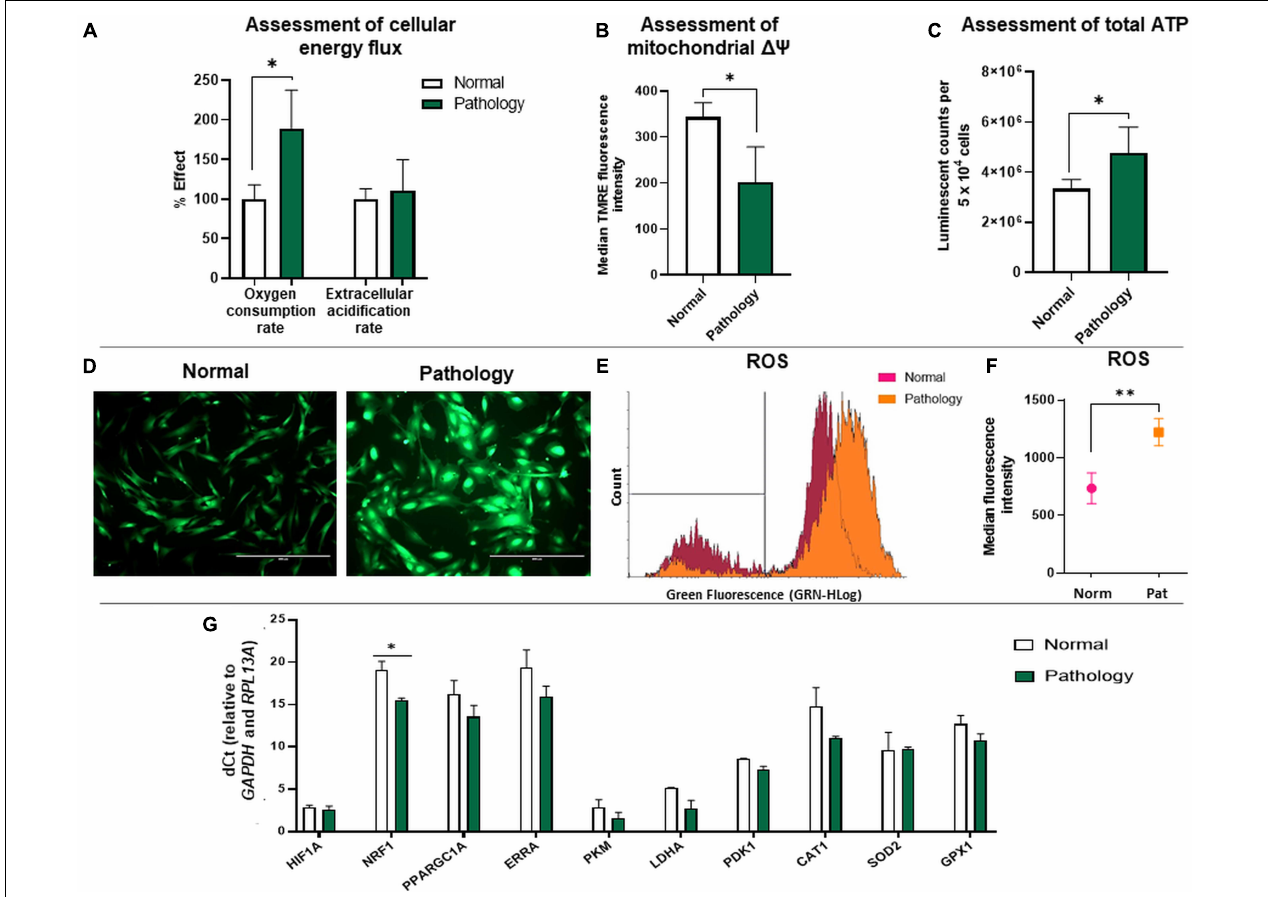
FIGURE 2 | Cellular bioenergetics analysis of hAFSCs from normal and fetus-affected gestations. (A) Assessment of cellular energy flux for hAFSCs, obtained from fetus-unaffected (Normal, n = 3) and fetus-affected (Pathology, n = 3) gestations, shown as a percentage relative to hAFSCs from fetus-unaffected gestations. Comparative measurements were taken using Abcam Extracellular oxygen consumption assay (ab197243) and Abcam Glycolysis assay (ab197244). (B) Analysis of mitochondrial membrane potential ( (cid:49) ψ m) of hAFSCs, obtained from fetus-unaffected (Normal, n = 3) and fetus-affected (Pathology, n = 3) gestations; values are indicated as mean ± SD. Analysis was performed using Abcam TMRE Mitochondrial membrane potential assay kit (ab113852). (C) Assessment of cellular energy content (ATP) of hAFSCs, obtained from fetus-unaffected (Normal, n = 3) and fetus-affected (Pathology, n = 3) gestations. Measurements were performed using Abcam Luminescent ATP detection assay kit (ab113849). (D–F) ROS production measurement in hAFSCs, obtained from fetus-unaffected (Normal, n = 3) and fetus-affected (Pathology, n = 3) gestations, performed using Abcam DCFDA Cellular ROS detection assay kit (ab113851). Qualitative evaluation with fluorescence microscopy (D) : representative images of ROS production in Normal and Pathology groups (scale bar = 400 µ m). Quantitative evaluation with flow cytometry (E,F) representative images of ROS production (E) and median fluorescence intensity evaluation (F) in Normal and Pathology [Pat2] groups. (G) RT-qPCR analysis of genes related to cell metabolism and respiration: HIF1A , NRF1 , PPARGC1A , ERRA , PKM , LDHA , PDK1, CAT1, SOD2 , and GPX1 in control hAFSCs from normal and fetus-affected gestations. mRNA expression levels were normalized to GAPDH and RPL13A and presented as mean values of (cid:49) Ct ± SD. *Denotes